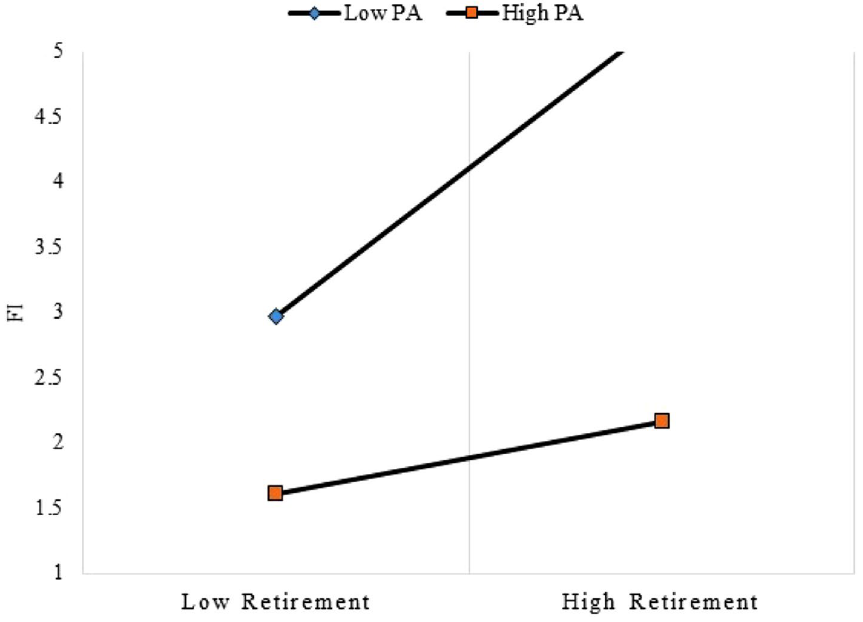
Figure 3. Physical activity (PA, the moderator) dampens the association of retirement with functional impairment (FI) in the ≥ 65 age